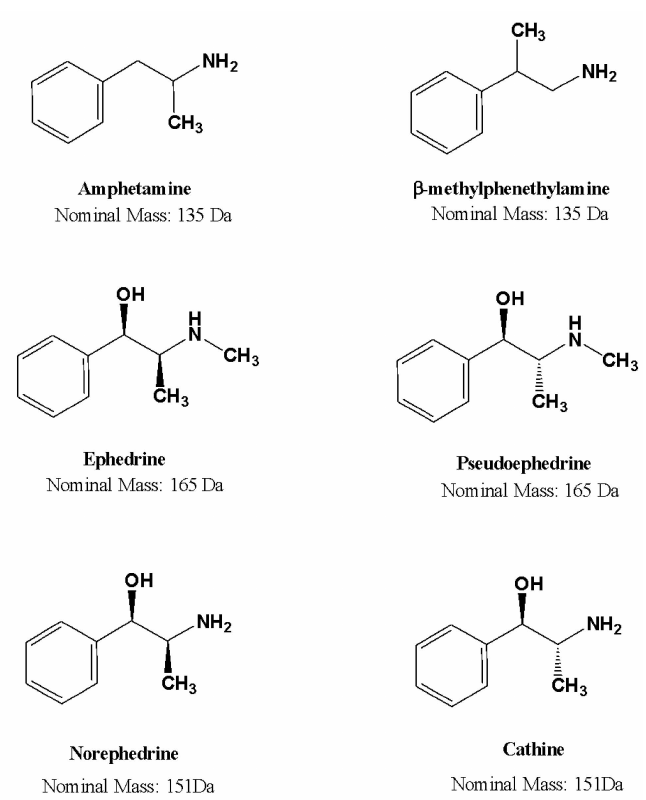
Figure 1. Chemical structures of amphetamine-related drugs included in this